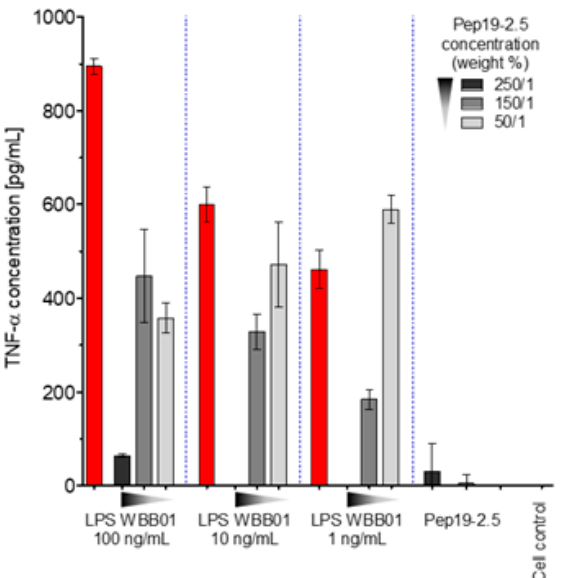
Figure 6. LPS-induced activation of human mononuclear cells after removal of the external peptide. Pep19-2.5 was added to the cells for 30 min, and after that, the cells were washed for 30 min to remove any free peptide. Finally, the cells were stimulated with LPS. Mean values and standard deviations due to the determination of TNF α in duplicate.